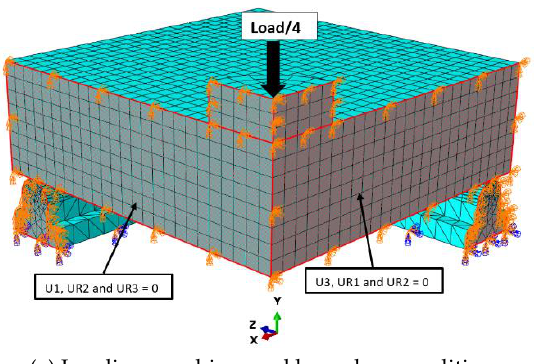
( b ) Strengthening skeleton Figure 16. Model of NC-PT slab.